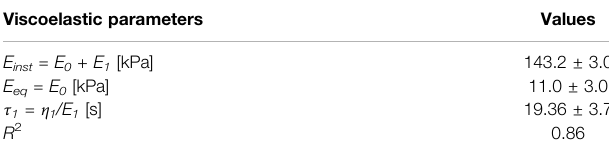
TABLE1| Viscoelasticparametersofprimaryciliaderivedfrom fi ttingexperimental data and the Maxwell-type SLS model of primary